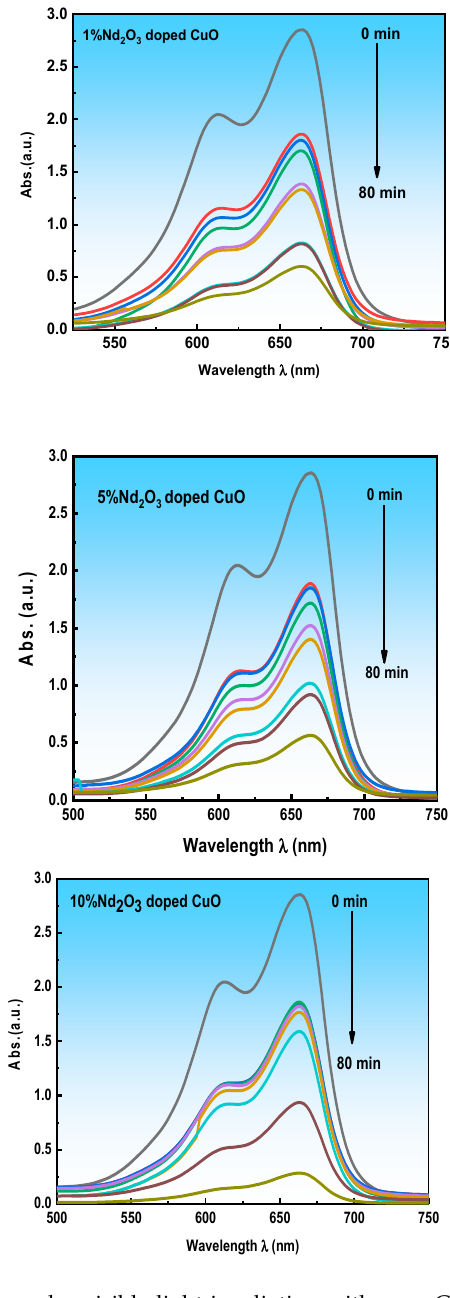
Figure 5. Absorption spectra of MB dye under visible light irradiation with pure CuO and five different concentrations of nanostructured Nd-doping CuO.